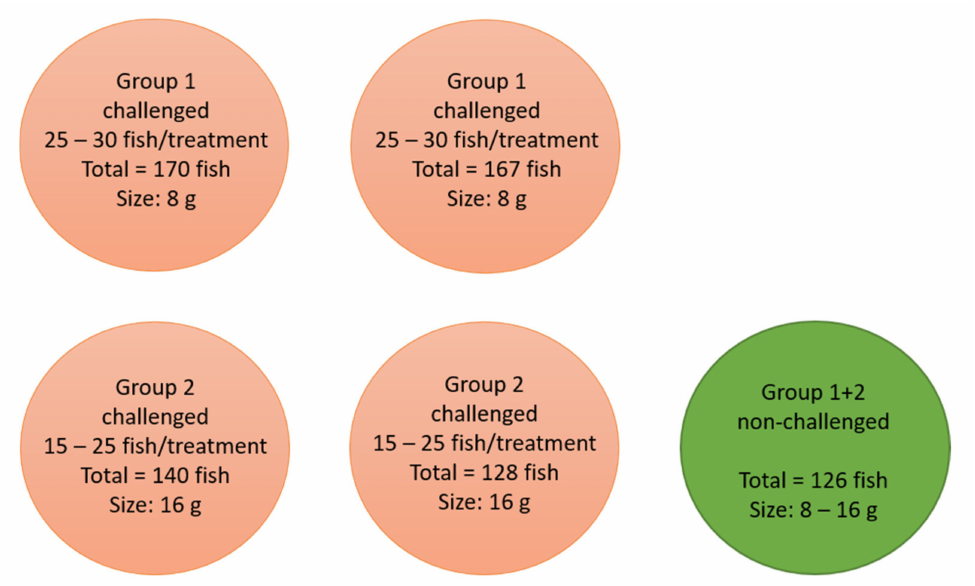
Figure 1. Setup during challenge in Study 2 (DTU). The fish were kept in cylindrical 180 L tanks with aerated saltwater (12‰) at 26 ◦ C ( ± 1 ◦ C). A bio-filter pump was installed in each tank and the wastewater was UV and heat